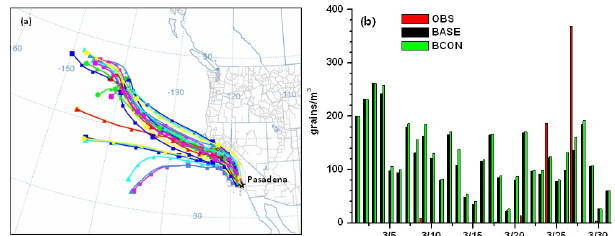
Fig. 10. Sensitivity study for oak pollen simulation during the episode around 27 March 2010 at Pasadena, California, with (a) three-day back trajectories from HYSPLIT; and (b) model evalua- tion with pollen concentration boundary conditions from outer do- main (BCON) and without